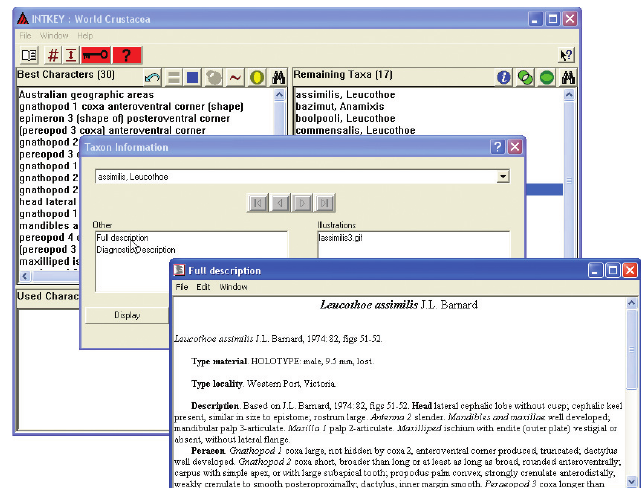
Figure 54. Full description of a